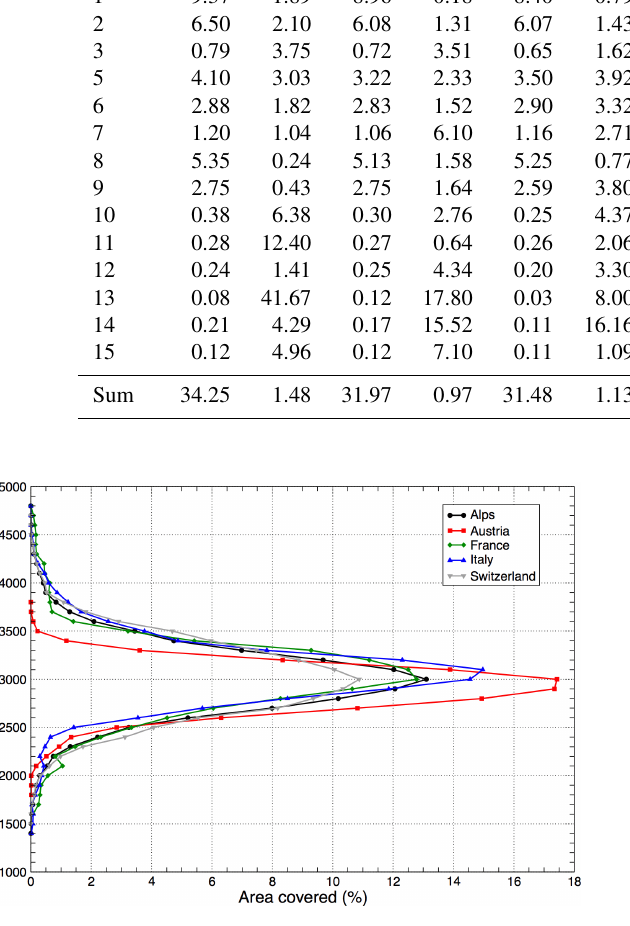
Figure 8. Normalized glacier hypsometry per country as derived from the AW3D30 DEM.